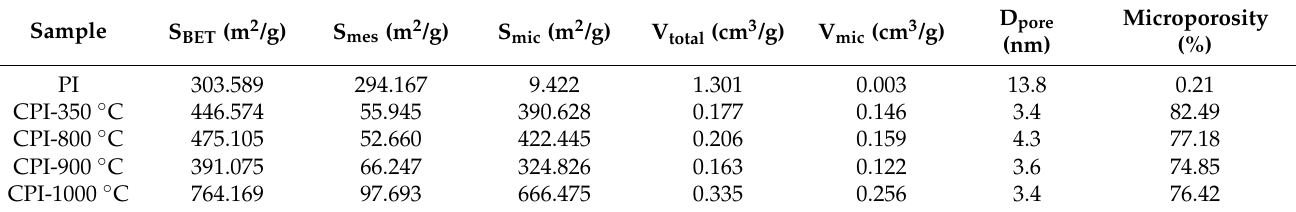
Table 1. Structural properties of PI and